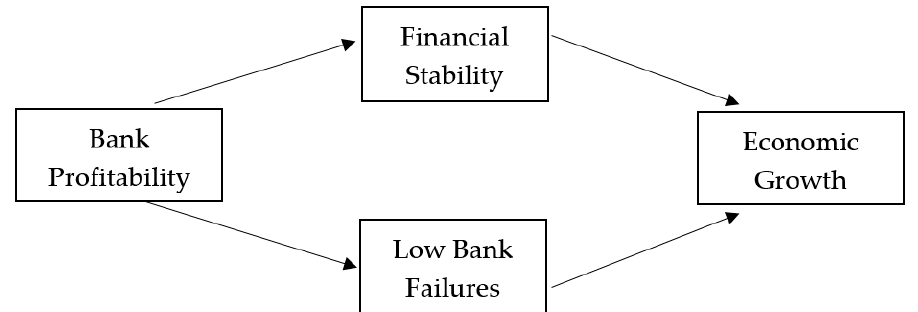
Figure A1. Conceptual nexus between bank profitability and economic growth. Notes: The figure shows that bank profitability leads to financial stability and results in low bank failures. Both financial stability and low bank failures promote economic growth.